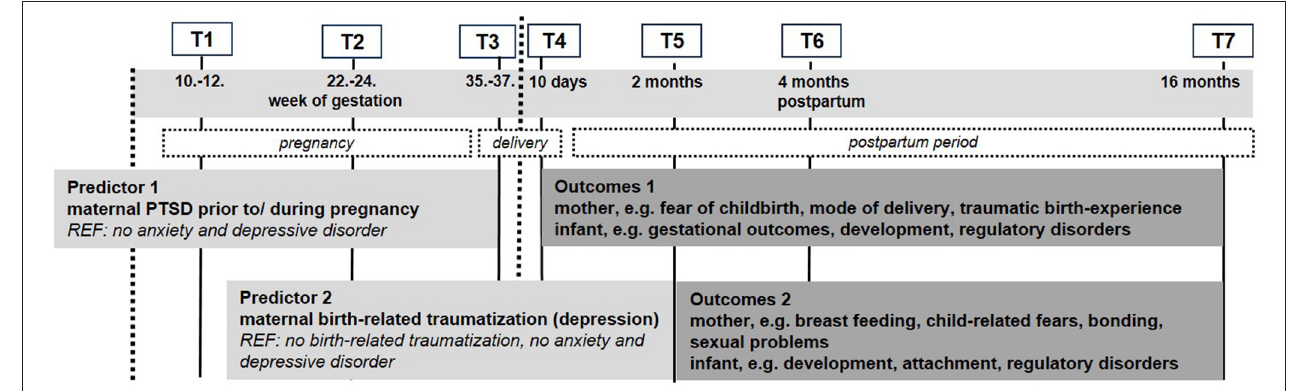
FIGURE 1 | Assessment waves, measures and outcomes for the post-hoc analyses of lifetime PTSD and birth-related traumatization with maternal and infant outcomes.